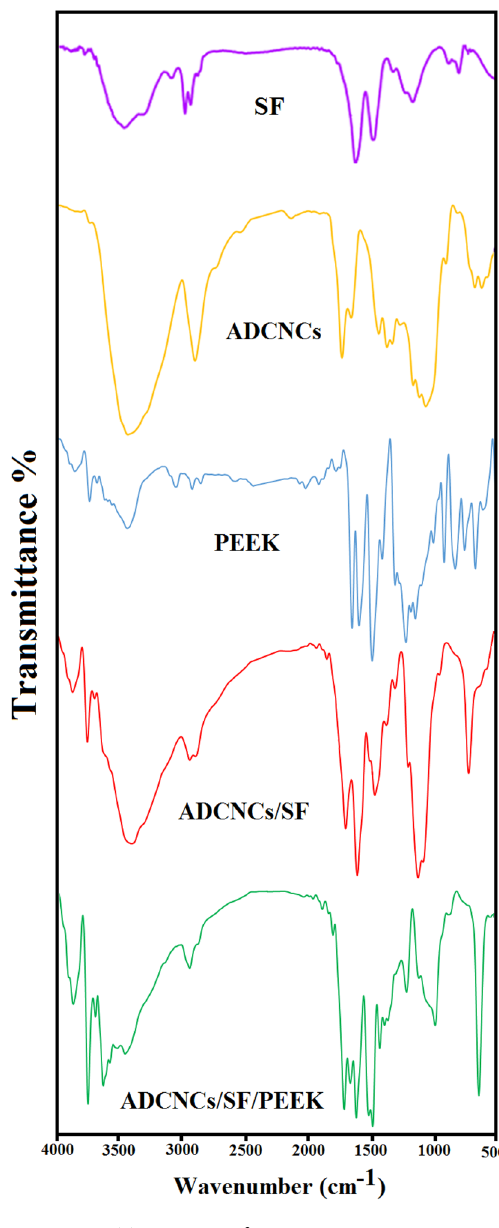
Figure 1. FTIR Spectra of ADCNCs, SF, PEEK, ADCNCs/SF, and